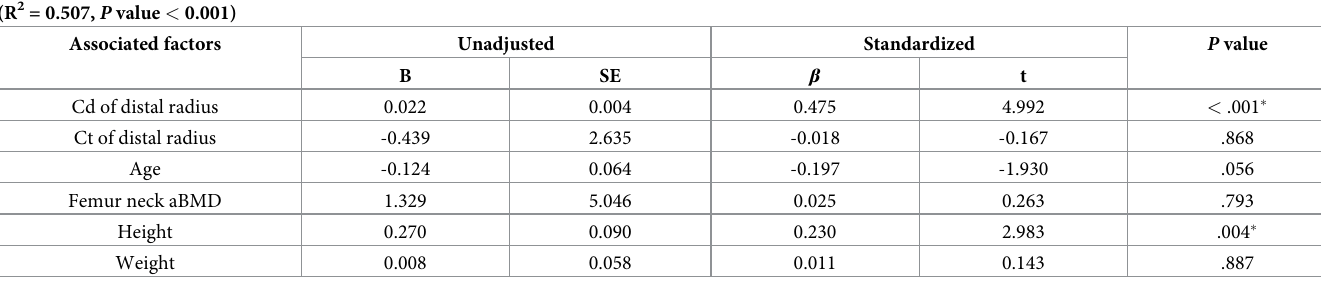
Table 5. Multivariate linear regression analysis of factors related to handgrip strength. (R 2 = 0.507, P value <